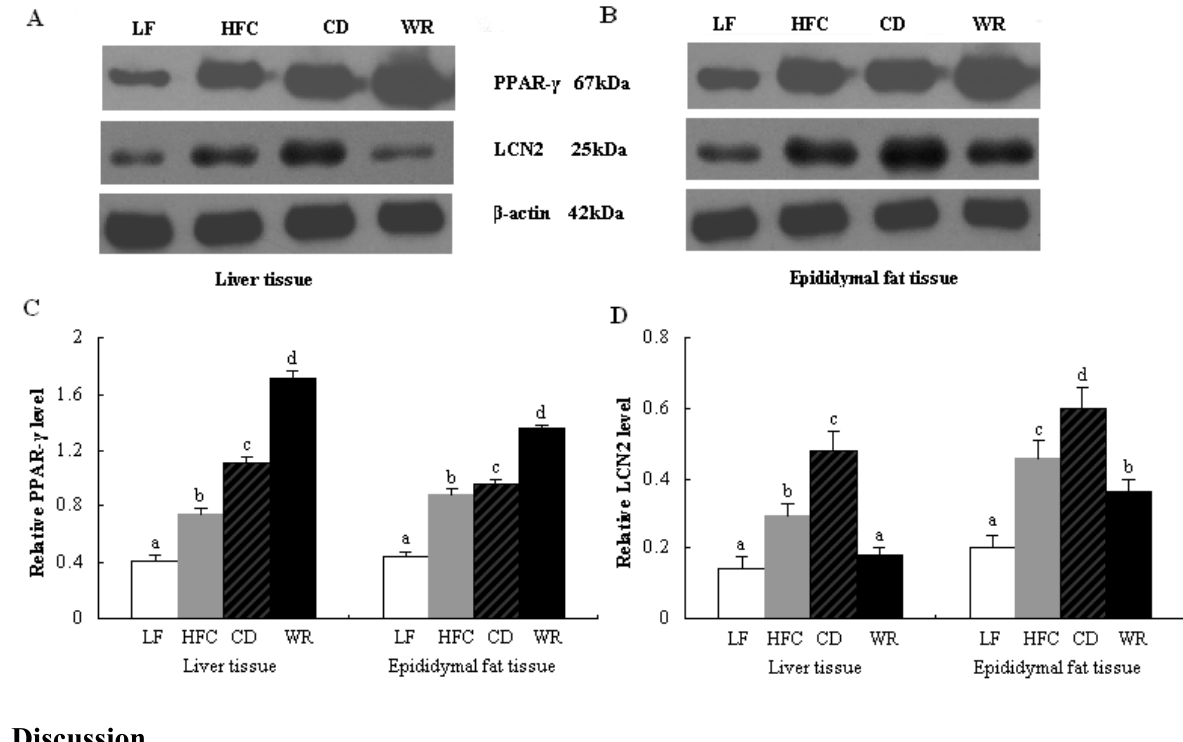
Figure 3. Protein expression of PPAR-γ and LCN2 in liver and epididymal adipose tissues of rats fed with different experimental diets by Western blot. The intensity of the bands was quantified by densitometric analysis and normalized with corresponding β-actin. Values are expressed as the mean ± SD for five rats. Bars without a common superscript letter indicate significant differences among groups at p < 0.05. LF: low-fat